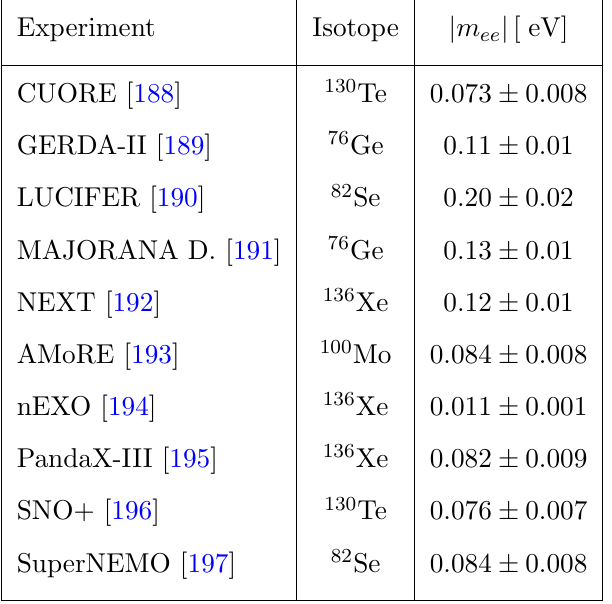
successfully the amount of BAU leaves viable only the hierarchical regime. For the NO, (cid:12)gure 7a, j m j can take values only below 0 : 04 eV, while a lower bound at about 4 (cid:2) 10 (cid:0) 4 ee